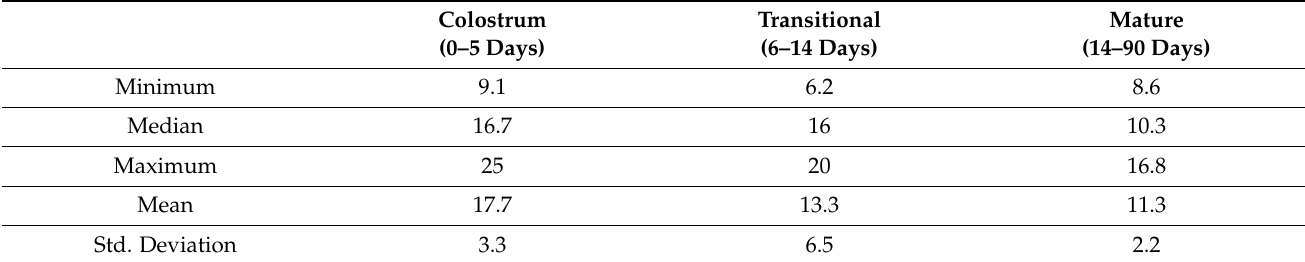
Table 8. Descriptive statistics (g/L) of the total HMO fraction throughout lactation (data from 12